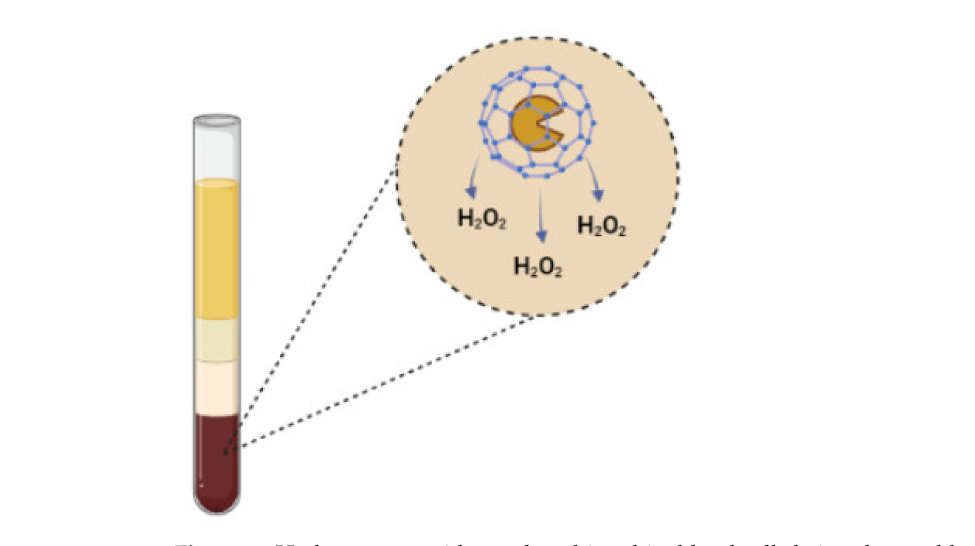
Figure 8. Hydrogen peroxide produced in white blood cells being detected by an enzyme–MOF biosensor produced using catalase, which is responsible for metabolizing this chemical compound in the body.